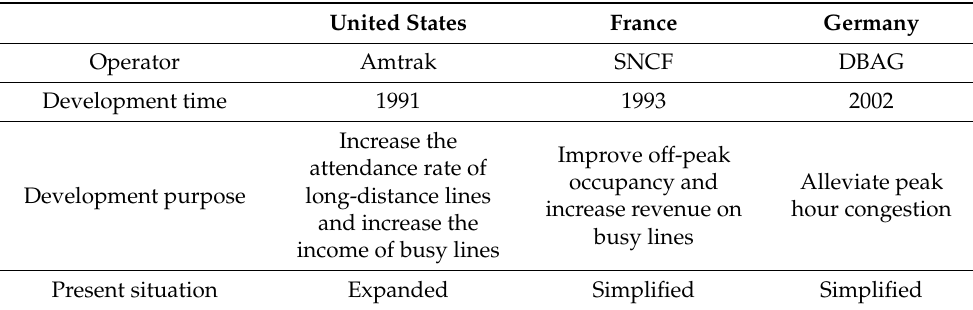
Table 2. The existing revenue management